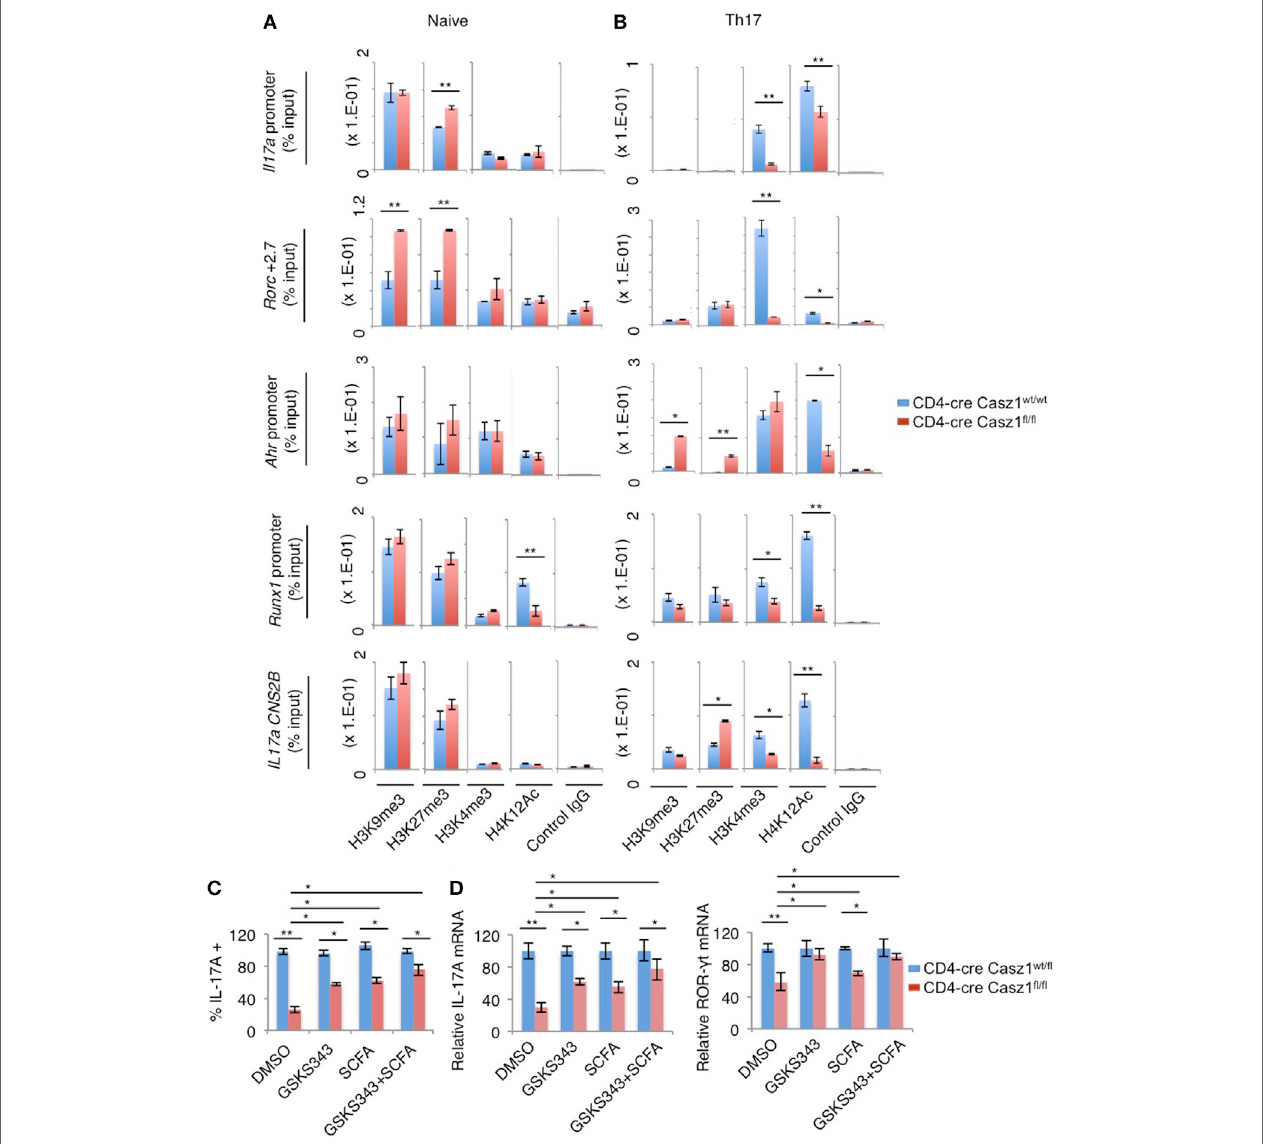
FigUre 7 | Casz1 promotes the expression of Th17 genes by affecting chromatin modifications in Th17 lineage genes. Casz1 + / − WT (blue) or Casz1 knockout (red) naïve cells were fixed (a) , or stimulated as in Figure 3B for 4–5 days before fixation (B) , for chromatin immunoprecipitation using α -H3K9me3, α -H3K27me3, α -H3K4me3, α -H4K12Ac, or control IgG antibodies and qPCR primer pairs for the indicated genes. Casz1 + / − heterozygous (blue) or Casz1 knockout (red) naïve CD4 + cells were stimulated under Th17 conditions as in Figure 3B for 4 days in the presence of dimethyl sulfoxide or the indicated inhibitors. The frequency of IL-17A + cells was determined by flow cytometry (gated on CD4 + CD44 high cells) (c) Antigen presenting cells were removed by MACS purification of CD4 + T cells before determining the mRNA levels of IL-17A (left) and RAR-related orphan receptor- γ t (right) in CD4 + T cells by qPCR (D) . Results represent 3 independent experiments. * P < 0.05, as determined by unpaired Student’s t